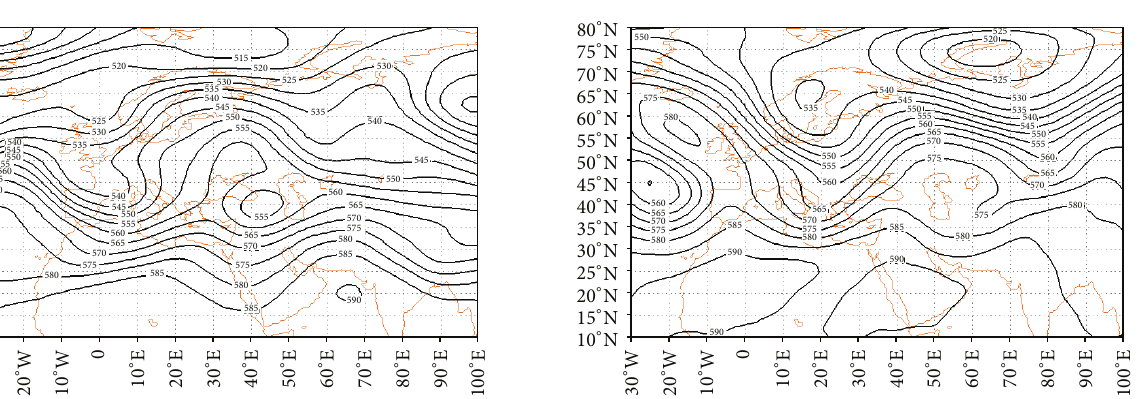
Figure 26: Geopotential elevation map at level 500 HPa in the representative day of pattern A.